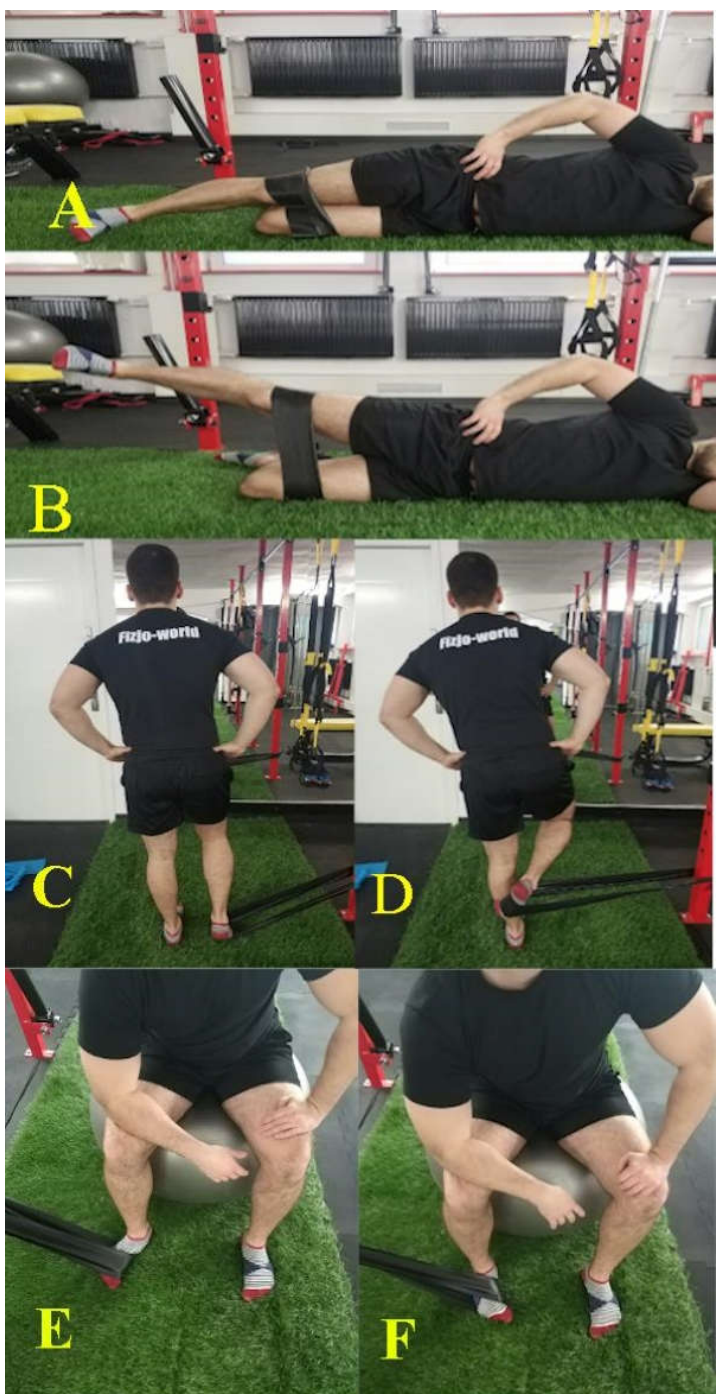
Figure 3. Initial and final exercise position. ( A , B )—exercise of gluteus medium, ( C , D )—exercise of politeus, ( E , F )—exercise of posterior tibalis.